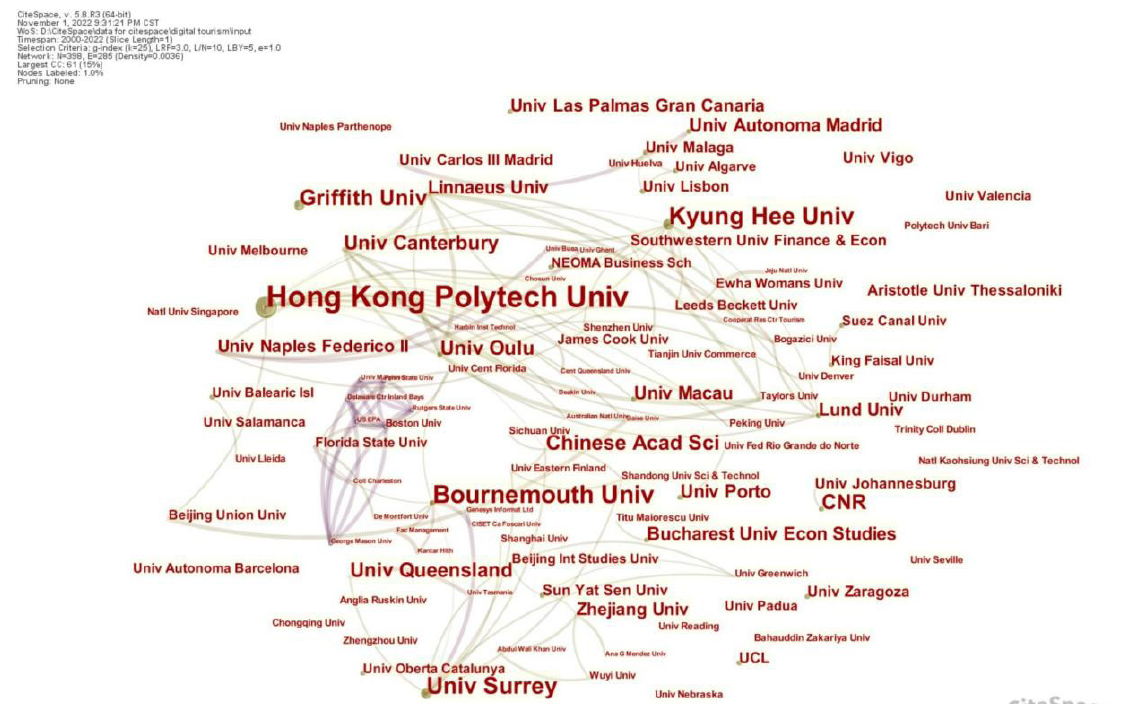
Figure 3. Knowledge map of institutional cooperation in digital Table 2. Core institutions in digital tourism research